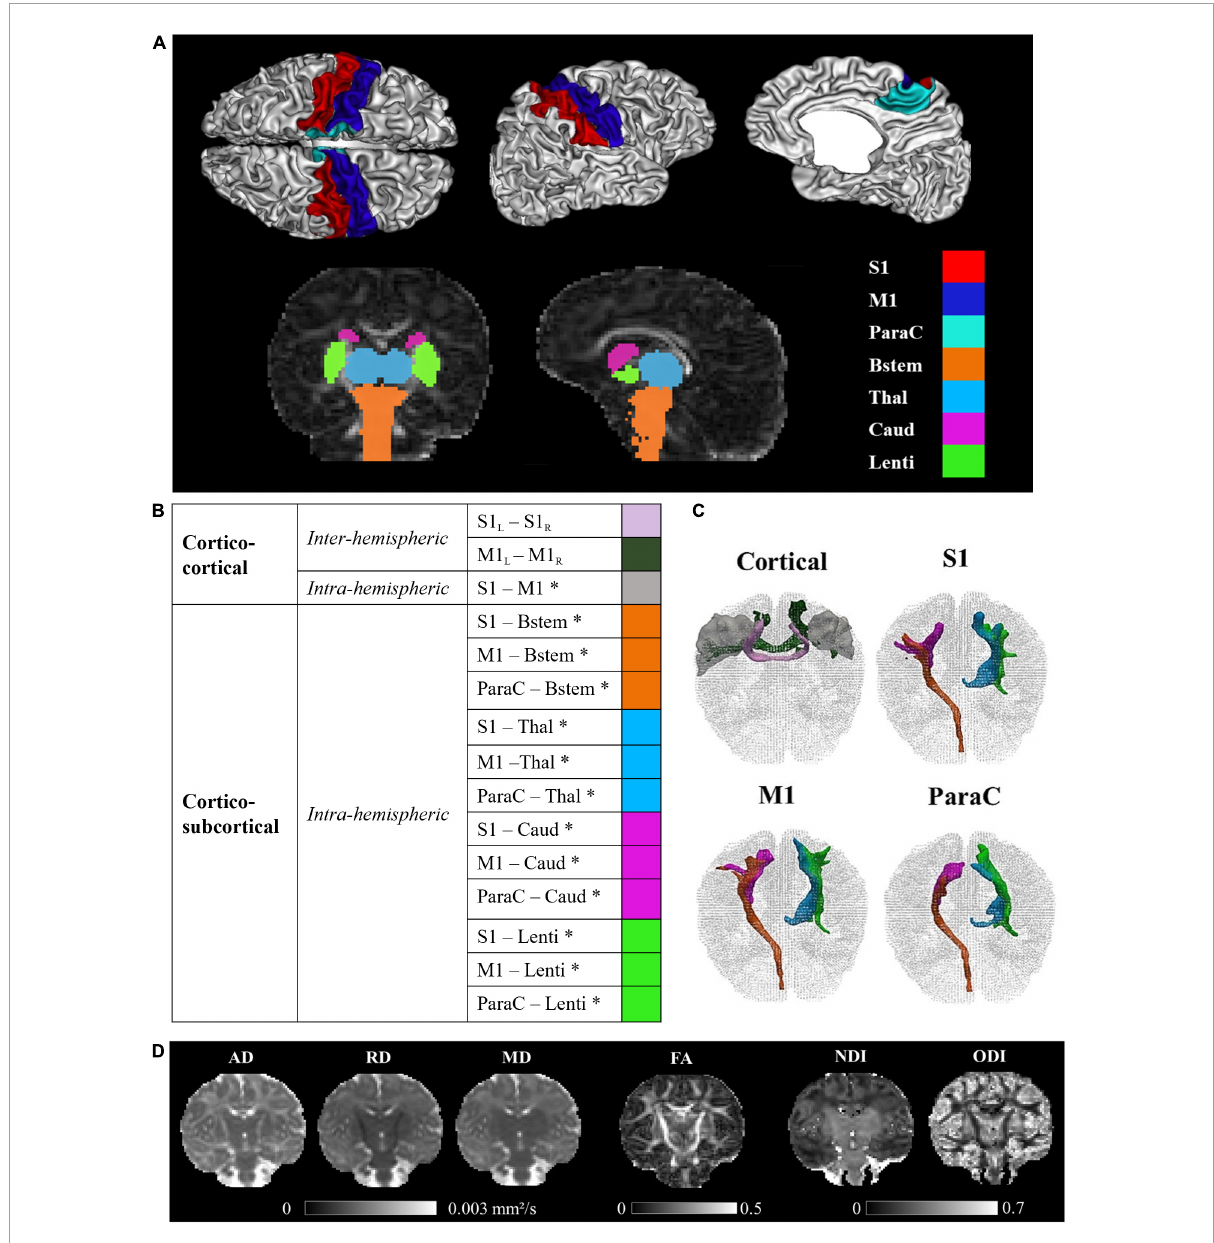
FIGURE1 Regions of interest, sensorimotor tracts, and diffusivity metrics for a representative full-term infant (GA at birth 40.4w, PMA at MRI 44.1w). (A) Visualization of the cortical and subcortical ROIs used as tractography seeds. (B) List of the SM tracts of interest. (C) 3D reconstructions of SM tracts. (D) Metric maps resulting from DTI (AD, RD, MD, FA) and NODDI (NDI, ODI) models. GA, gestational age (in weeks); PMA, post-menstrual age (in weeks); ROIs, regions of interest; SM, sensorimotor; S1, lateral portion of the primary somatosensory cortex (postcentral gyrus); M1, lateral portion of the primary motor cortex (precentral gyrus); ParaC, medial portions of the primary sensorimotor cortices (paracentral area); Bstem, brainstem; Thal, thalamus; Caud, caudate nucleus; Lenti, lenticular nucleus; L, left; R, right. ∗ Intra-hemispheric tracts, evaluated in left and right hemispheres separately. DTI, diffusion tensor imaging; metrics: AD, axial diffusivity; RD, radial diffusivity; MD, mean diffusivity; FA, fractional anisotropy; NODDI, neurite orientation dispersion and density imagingmetrics; NDI, neurite density index; ODI, orientation dispersion